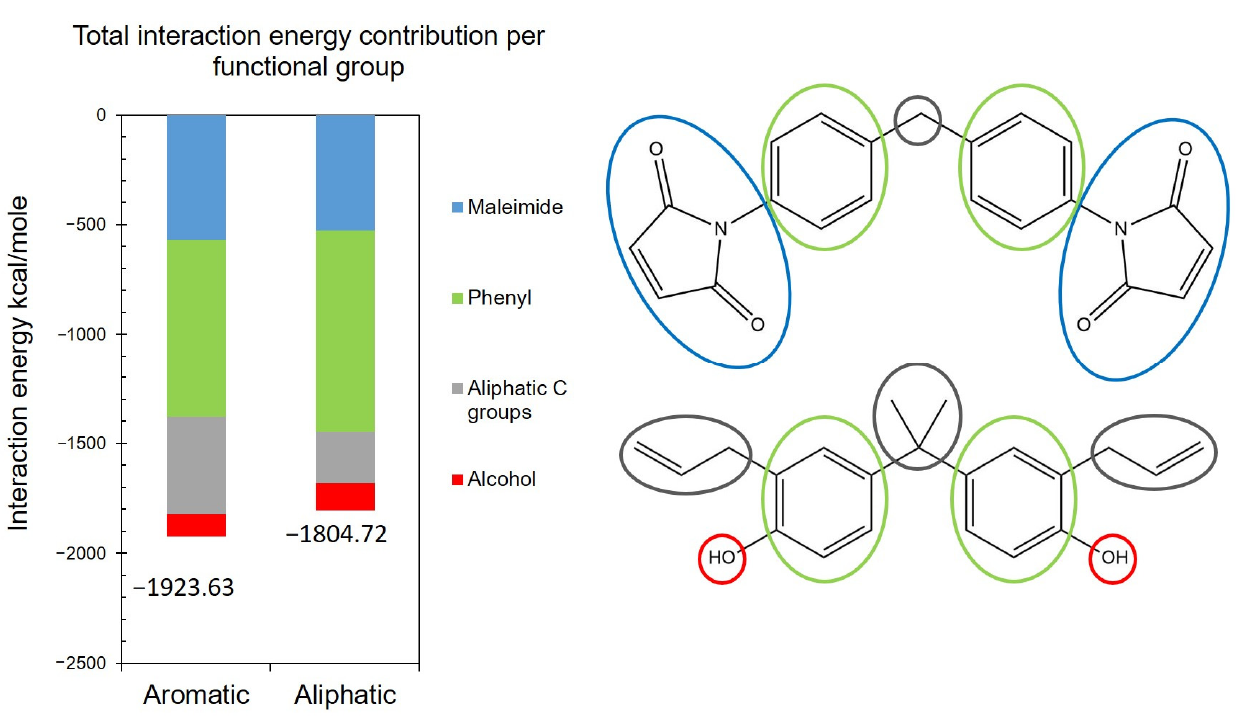
Figure 16. Interaction energy contribution by functional group in the BMI system for both aromatic and aliphatic surfaces.